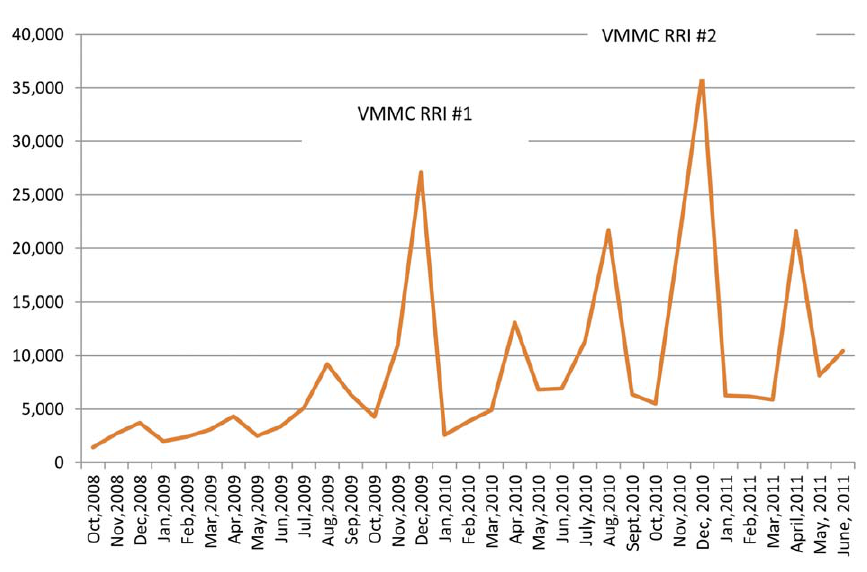
Figure 2. Monthly circumcisions done in Kenya, 2008–2011.